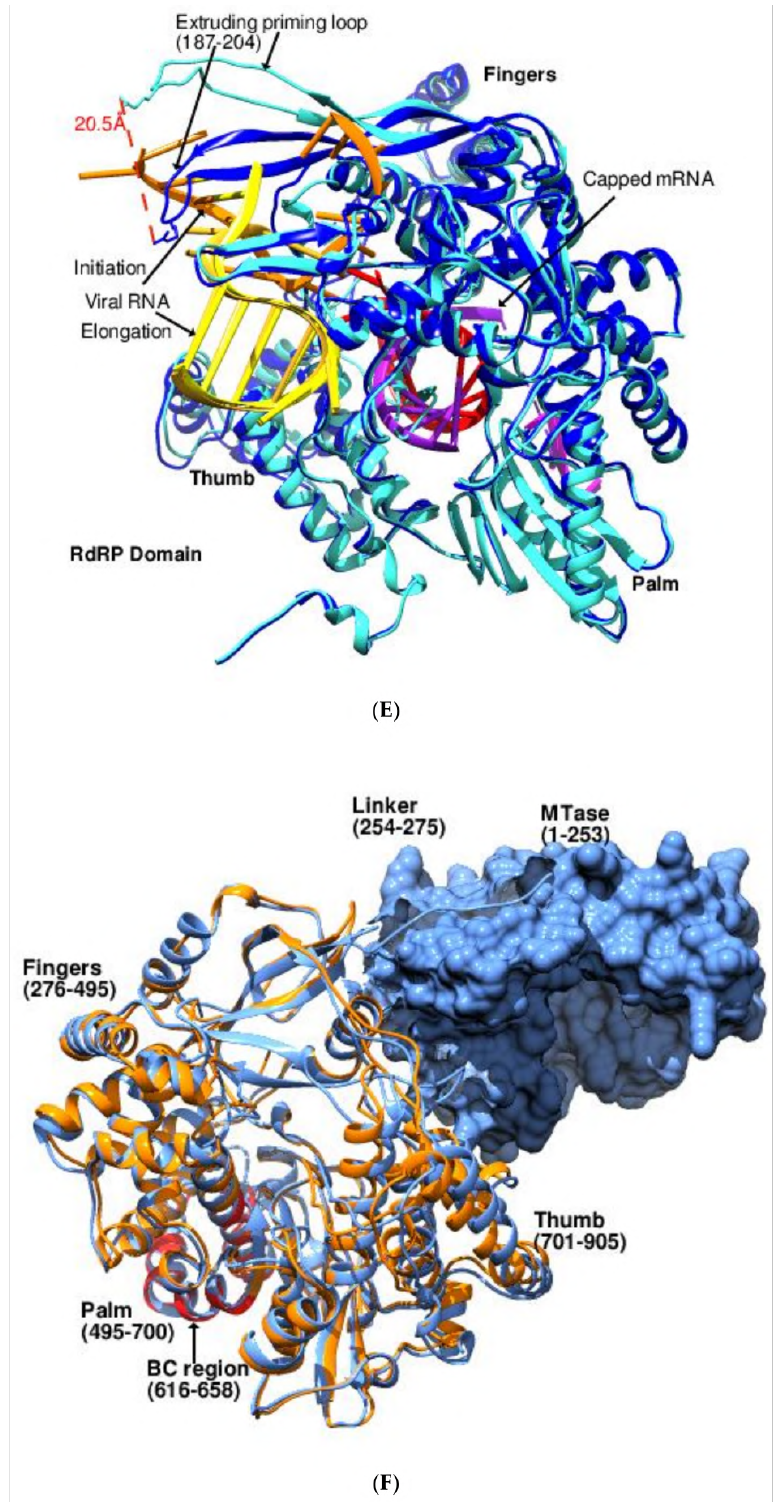
Figure 8. Motifs, pockets, and their role in replication. ( A ) The configuration of the motif F in the apo and the template-bound states of TAV RdRP. The reorganization of motif F in the bound (green, PDB 7OM6) and unbound (blue, PDB 7OM9) states is highlighted. The template and the product strands are shown in yellow and orange, respectively. ( B ) Picornaviral EV71 RdRPs at the translocation start stage (PDB 6LSE, light blue surface) with the template (yellow) and product (orange) RNAs represented as